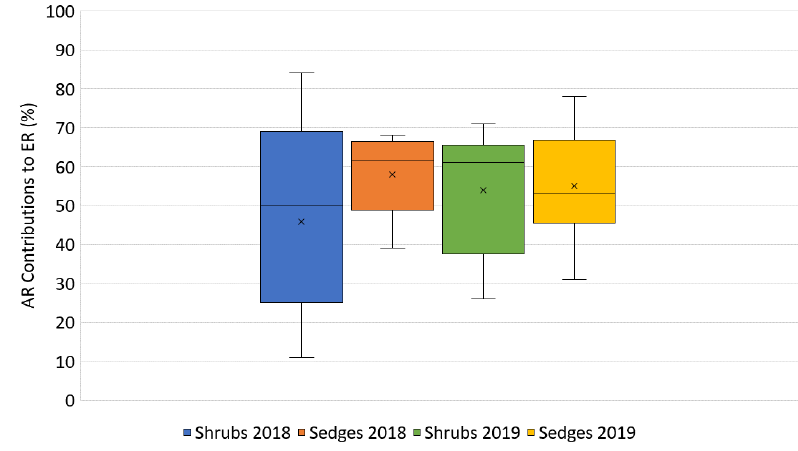
Figure 5. AR contributions (%) to ER across the growing seasons of 2018 and